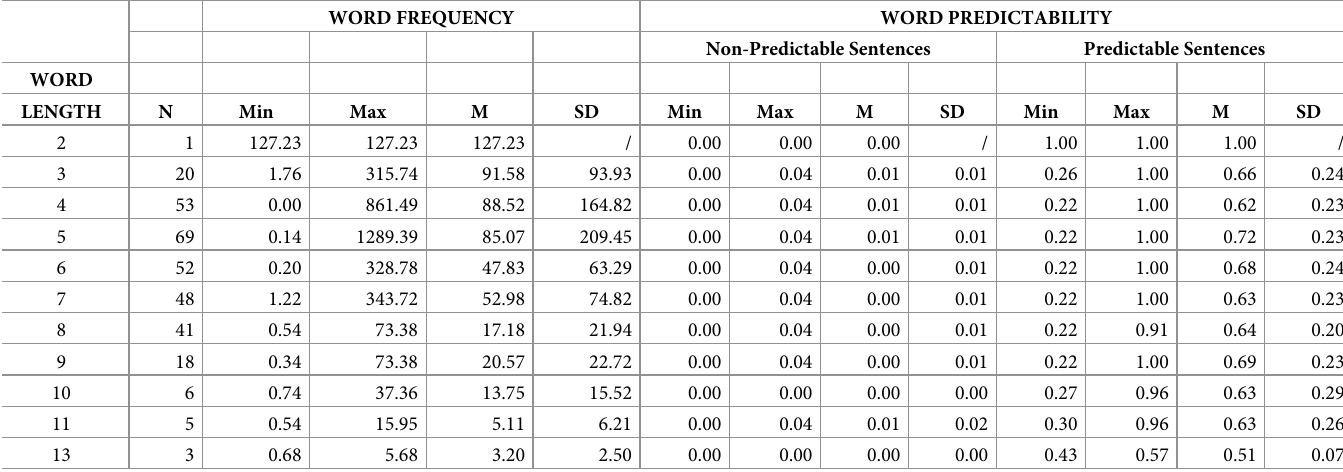
Table 1. Properties of the test